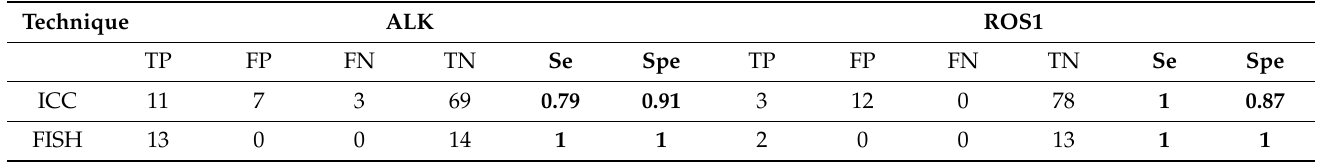
Table 2. Sensitivity and specificity of ICC and FISH compared with NGS. FN, false-negative;